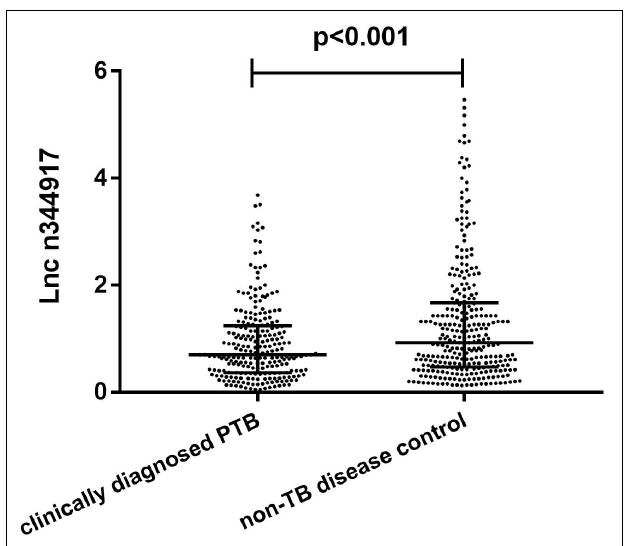
FIGURE 2 | Relative expression levels of lncRNA n344917 in clinically diagnosed PTB and non-TB disease